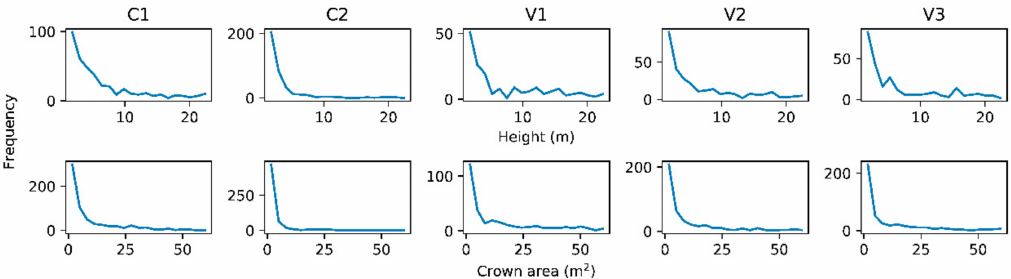
Figure 7. Size frequency distributions using both maximum crown height (m) and crown area (m 2 ) as proxies for tree size. Field surveys are unable to capture these comprehensive measures of tree